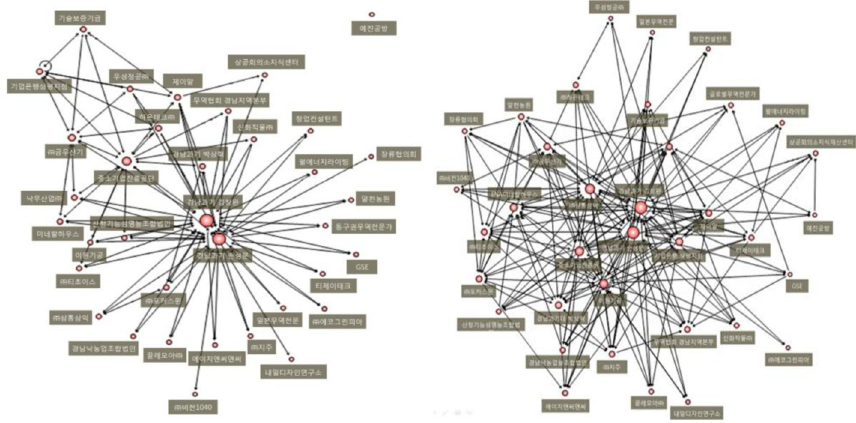
Figure 3. Changes in network structures after operating the